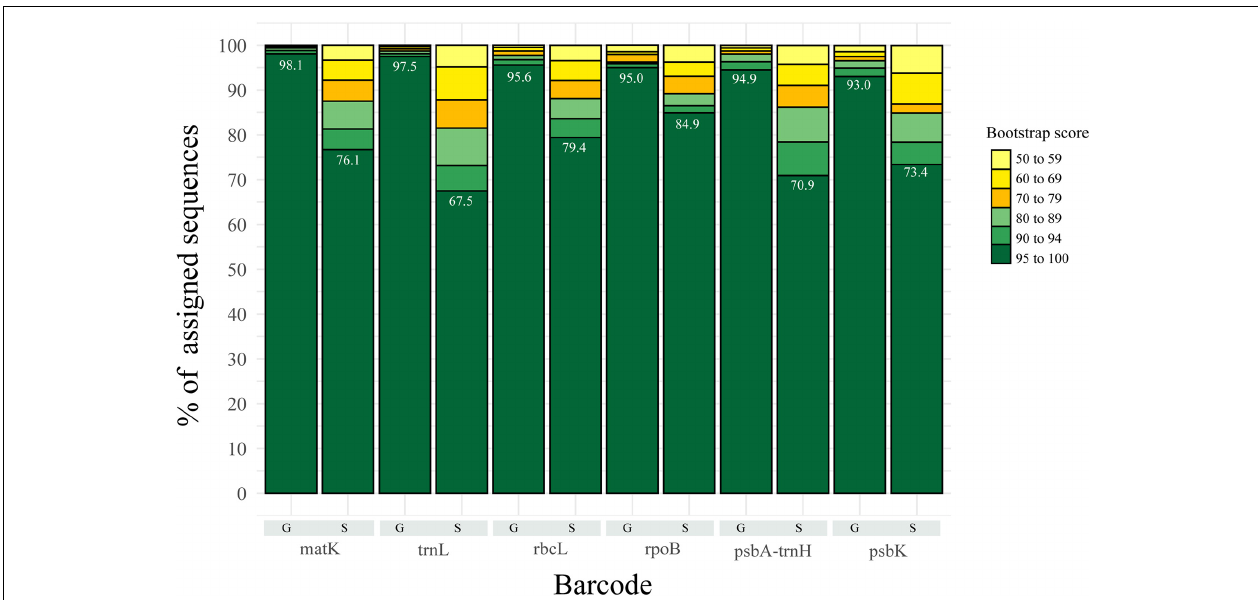
FIGURE 1 | Representation of the percentage of assigned sequences (i.e., classified) by the Bayesian Classifier at species and genus level for the 5–20 datasets. Shades of green represent the fraction of sequences with bootstrap values greater than 80 (proposed threshold for accuracy). Yellow represents the fraction of sequences with bootstrap values lower than 80, thus not used for further